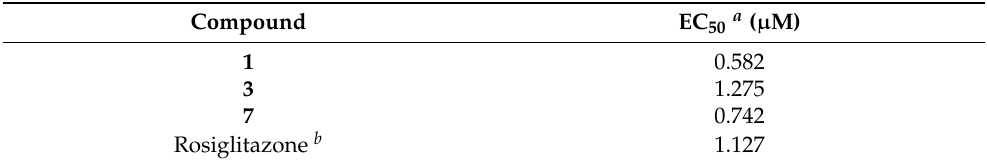
Figure 6. Effect of compounds 1 , 3 and 7 on glucose uptake in insulin-induced HepG2 cells ( 𝑥̅ ± s, n = 4). The 2-NBDG fluorescence measured by flow cytometry. Figure 7. Effect of compounds 1 , 3 and 7 on glucose uptake in insulin-induced HepG2 cells ( 𝑥̅ ± s, n = 4). ( A ) Compound 1 corresponding histograms of the mean fluorescence intensity of 2-NBDG; ( B )